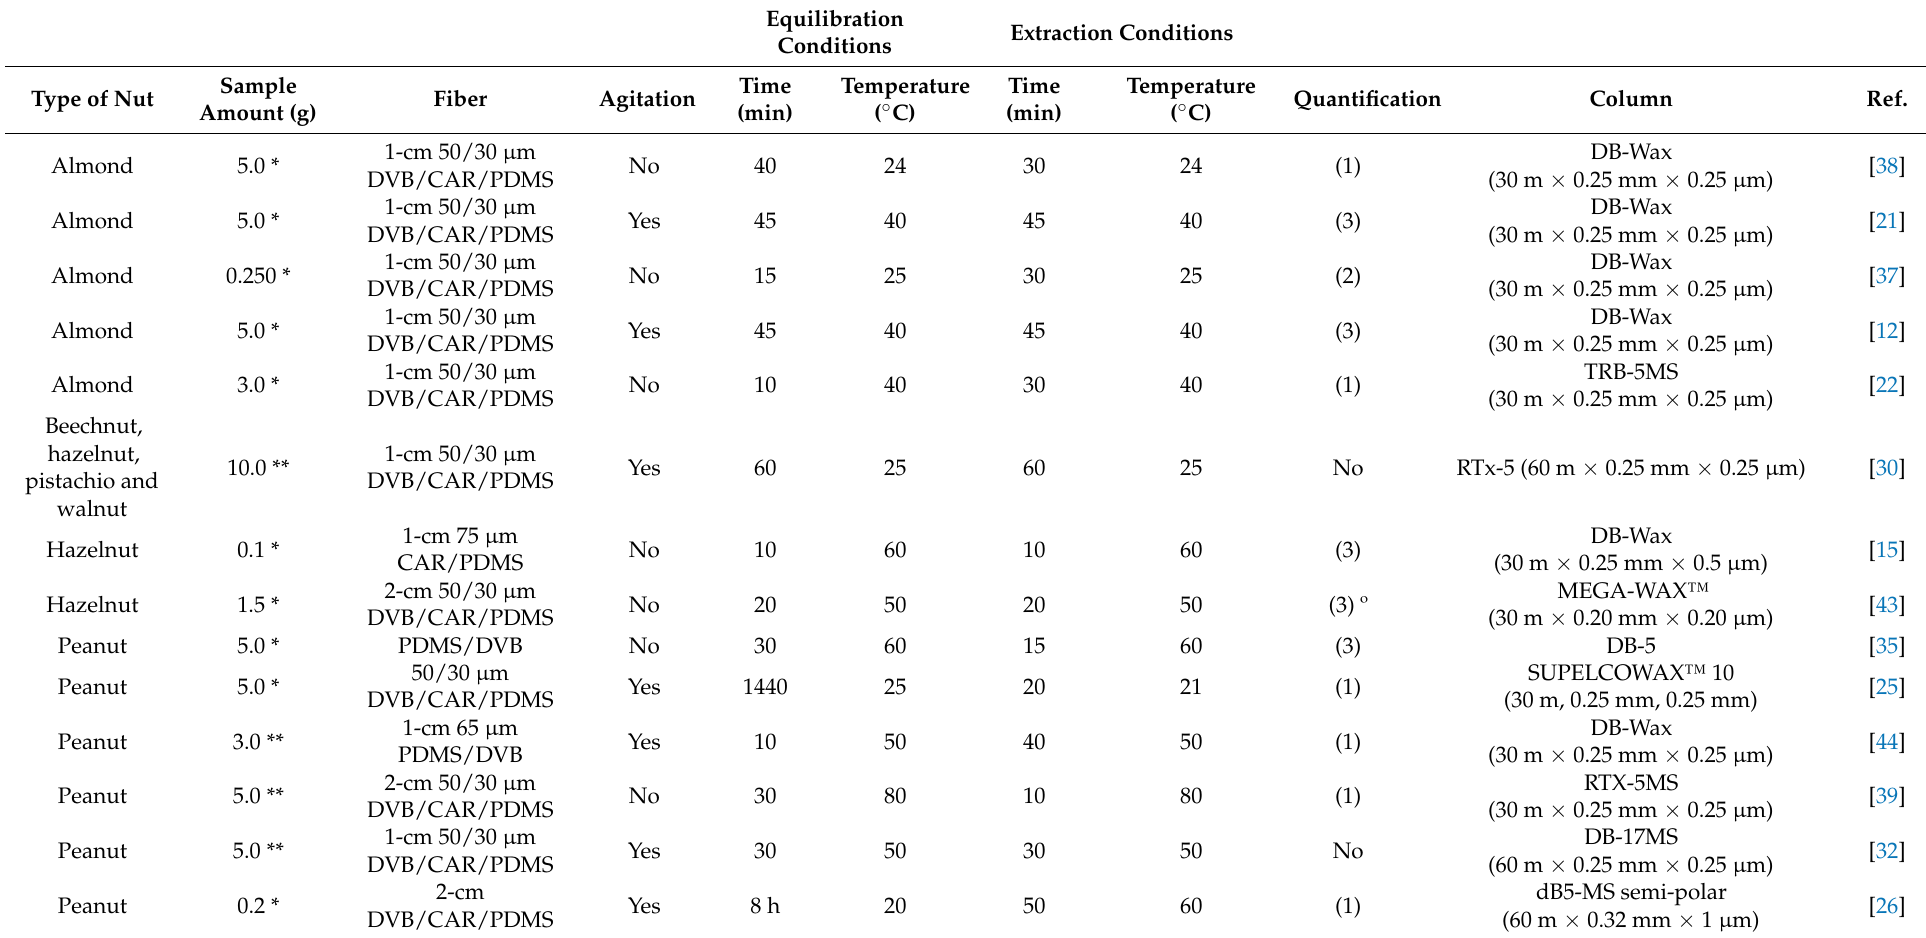
Table 1. Experimental SPME conditions (time and temperature values) of both steps, equilibration and extraction, commonly employed in VOCs analysis in nut